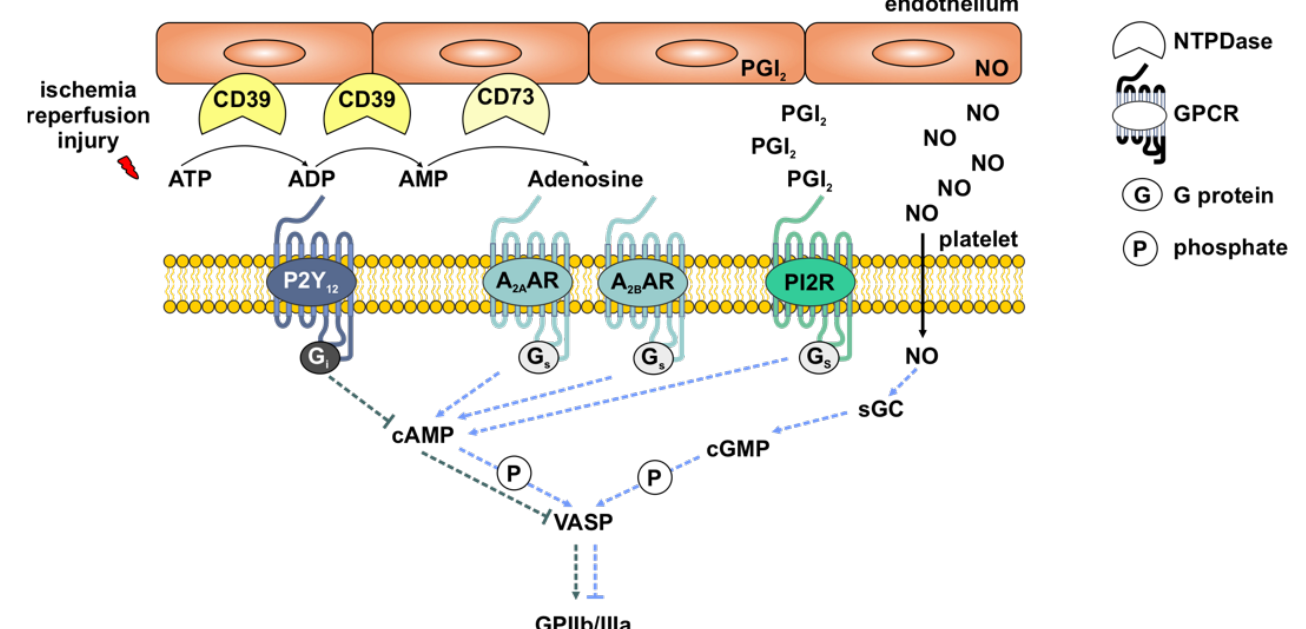
Figure 1. Simplified scheme of physiological signaling pathways in platelets. In platelets, G protein-coupled receptors (GPCR) act on the activation (P2Y 12 ) and deactivation (A 2A AR, A 2B AR, PI2R) of Glycoprotein IIb/IIIa (GPIIb/IIIa) via the phosphorylation of vasodilator-stimulated phosphoprotein (VASP). NTPDases (CD39, CD73) expressed in the endothelium contribute to the breakdown of extracellular ATP and ADP to AMP and adenosine. Prostacycline (PGI 2 ) and nitric oxide (NO) are released from the endothelium and support the deactivation of GPIIb/IIIa. ATP — adenosine triphosphate; ADP — adenosine diphosphate; AMP — adenosine monophosphate; cAMP — cyclic adenosine monophosphate; cGMP — cyclic guanosine monophosphate; sGC — soluble guanylyl cyclase; P2Y 12 — purinergic receptor; A 2A AR — adenosine A 2A receptor; A 2B AR — adenosine A 2B receptor.